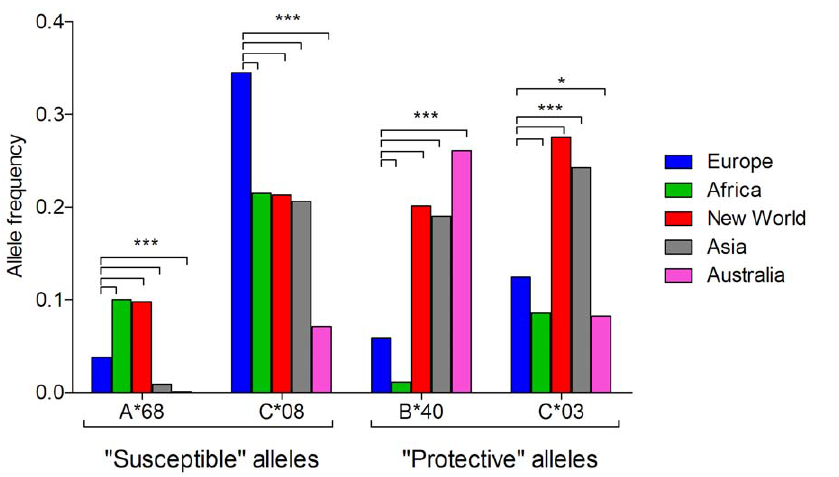
Figure 3. ‘‘Susceptible’’ and ‘‘protective’’ allele frequencies in world populations. The histogram displays the allele frequency of each ‘‘susceptible’’ and ‘‘protective’’ allele in various world populations. The North and sub-Saharan Africa were regrouped under Africa, North and South America were regrouped under New World, and Oceania, northwest, southeast, and southwest Asia were regrouped under Asia, Australia represents aboriginal populations only. *** P , 0.0001 and * P , 0.05 for Europe vs. comparison population.